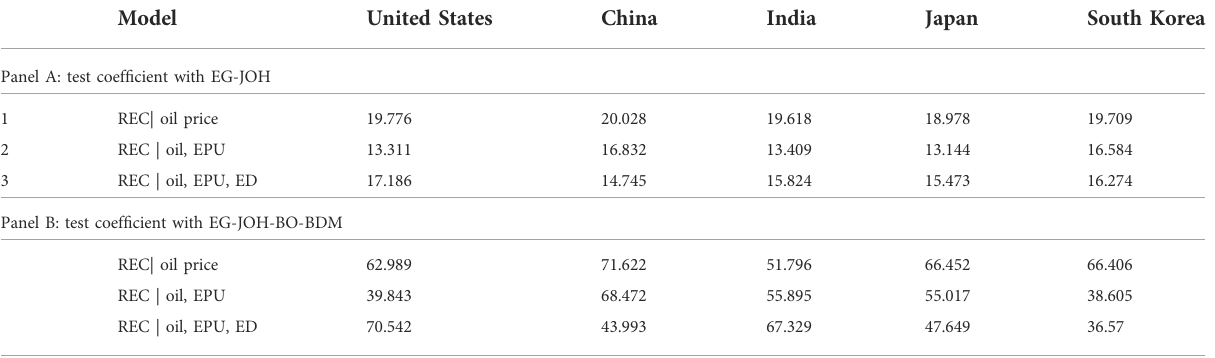
TABLE 4 Bayer and Hanck combined cointegration